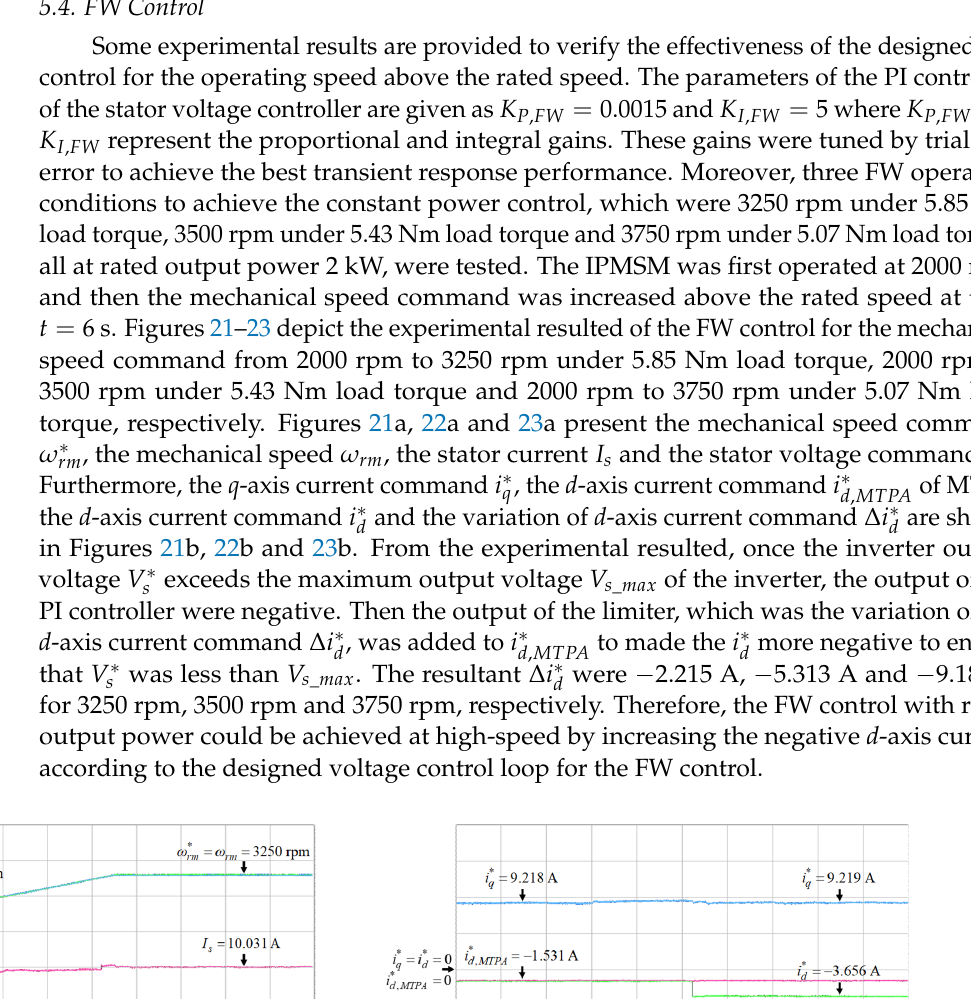
( b ) Figure 23. Experimental results of FW control from 2000 rpm to 3750 rpm under 5.07 Nm load torque: ( a ) mechanical speed command, mechanical speed, stator current and stator voltage command; ( b ) q -axis current command, d -axis current command of MTPA, d -axis current command and variation of d -axis current command. 6. Conclusions An IPMSM drive system with machine learning-based MTPA control in the constant torque region and an FW control in the constant power region was successfully developed in this study. Moreover, an ACSM speed controller was developed to improve the transient re- sponse of the speed control. In the intelligent MTPA control, first, the d -axis current com- mand which can achieve the MTPA control was derived. Then, the difference value of the dq- axis inductance of the IPMSM was obtained by a well-trained PPFNN-AMF and sub- stituted into the formula of d -axis current command to achieve the MTPA control and to alleviate the effect of the magnetic saturation. In the FW control, a voltage control loop was designed to limit the inverter output voltage to the maximum output voltage of the inverter by increasing the negative d -axis current at high-speed. Finally, some experi- mental results were provided to demonstrate the validity of the proposed high-perfor- mance control strategies of the IPMSM drive system, including the ACSM speed control, the intelligent MTPA control and the FW control. The main contributions of this study are listed as follows: (1) An ACSM speed con- troller considering nonzero d -axis current was proposed to improve the robustness of the speed control. Moreover, the Lyapunov stability theorem was used to derive the adaptive law, which was used for online estimation of the lumped uncertainty. (2) The PPFNN- AMF was adopted in this study to learn the difference value of the dq -axis inductance of the IPMSM offline. After the PPFNN-AMF was well-trained, the difference value of the